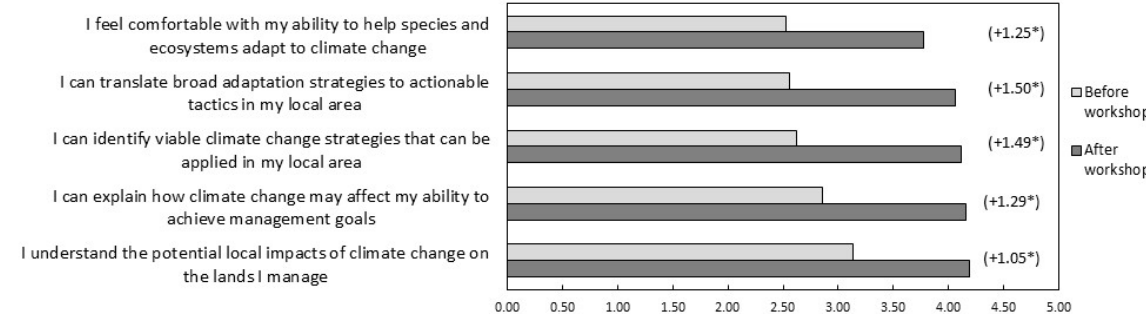
Figure 2. Summary of pre- and post-workshop assessment of participant’s level of knowledge of climate impacts and adaptation summarized from 467 evaluations (1 = Low level; 5 = High level). Parentheses indicate change between before and after workshop; * indicates p < 0.0001 for paired t-test comparing before and after workshop.